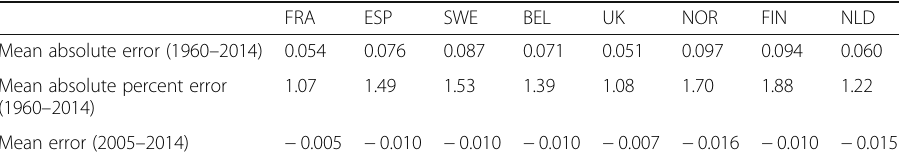
Table 11 Mean absolute (percent) error over the period 1960 – 2014 and mean error over